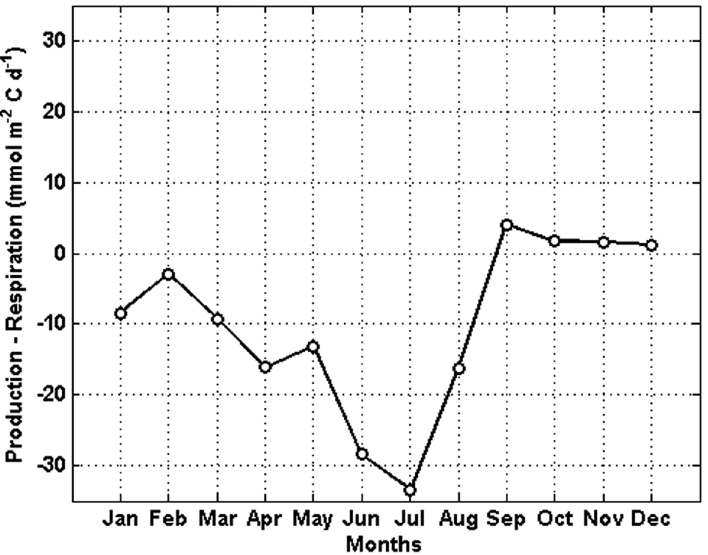
Fig. 6 – Monthly variation of the Ecosystem Net Metabolism (NEM) at the BJE. Negative and positive values indicate heterotrophy and autotrophy,